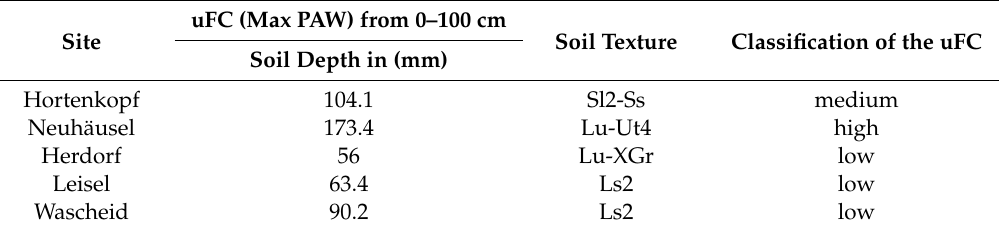
Figure 7. Drought (lower part of y -axis) and elevated daytime O 3 concentrations (upper part of y -axis) for the time period 1998–2019 in daily resolution at five forest sites in Rhineland-Palatinate, Germany. The vertical black lines indicate the start (1 April) and end of the vegetation period (30 September) in each year. The vegetation period (91–273 DOY) is highlighted in light brown. Table 6. The usable field capacity (uFC) as the di ff erence between field capacity (FC) and permanent wilting point (PWP) of the appropriate soils were calculated after Bodenkundliche Kartieranleitung [72] and classified according to uFC and di ff erent soil textures for all